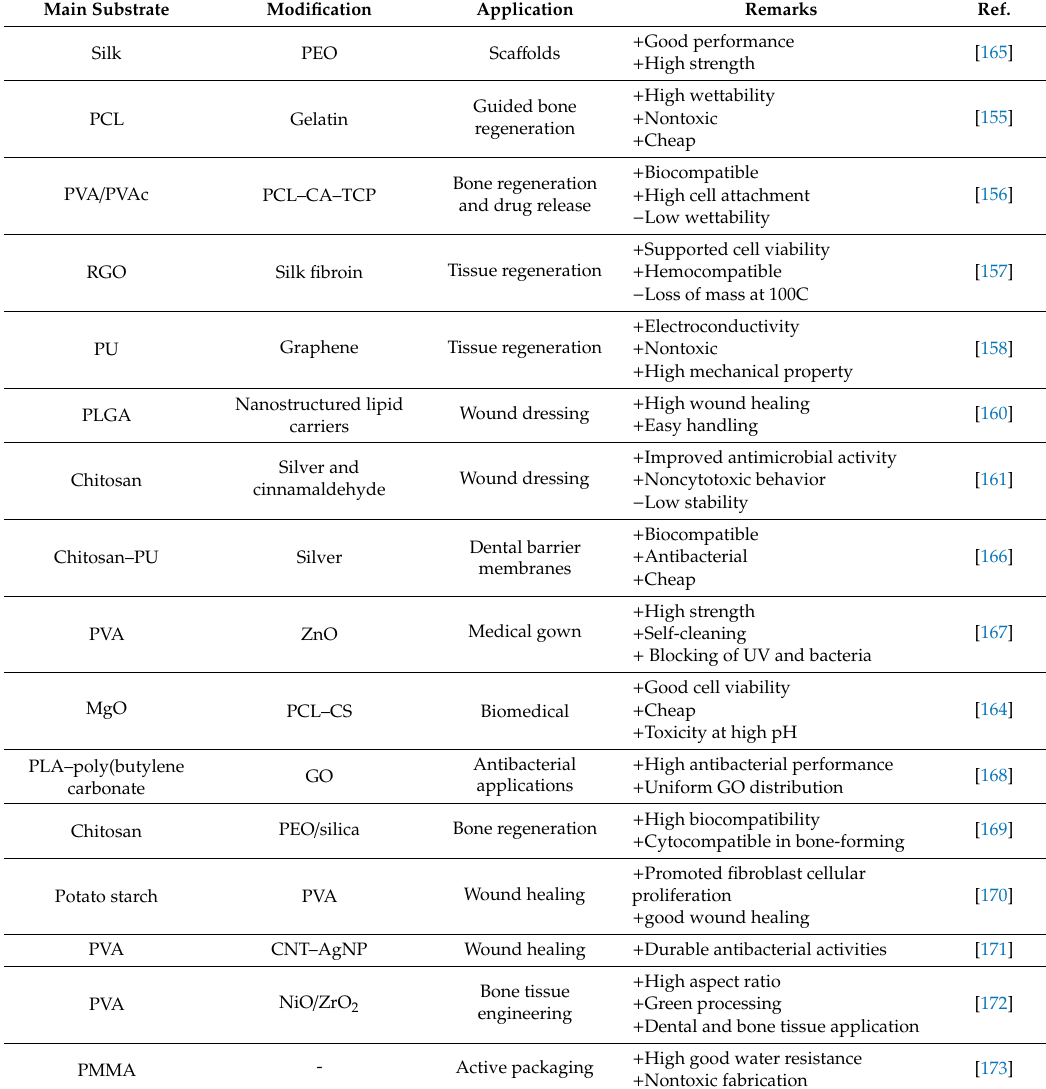
Table 3. Applications of modified and composite nanofibers in biomedical and healthcare